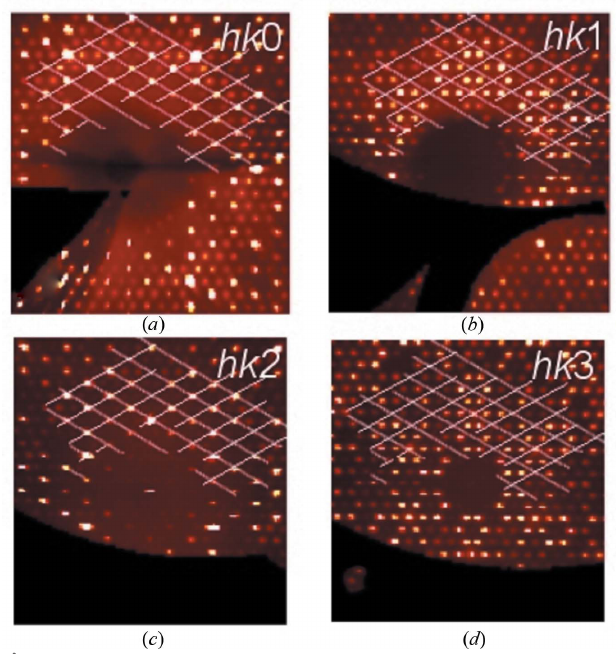
Figure 4 A scheme of the peculiar diffraction patterns in kaliophilite, based on the single-crystal X-ray diffraction experimental data. The four images show reconstructed sections of the reciprocal space, namely the planes ( a ) hk 0, ( b ) hk 1, ( c ) hk 2 and ( d ) hk 3. For comparison, the same grid is superimposed onto the four images, with nodes corresponding to reflections with h (cid:2) k = 3 n